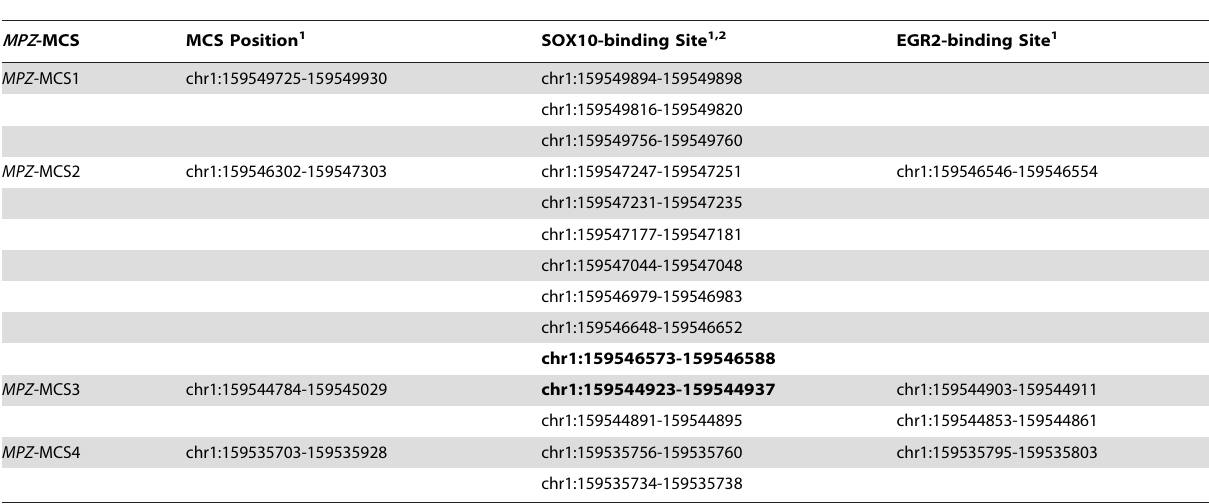
Table 1. Transcription factor-binding sites within MPZ